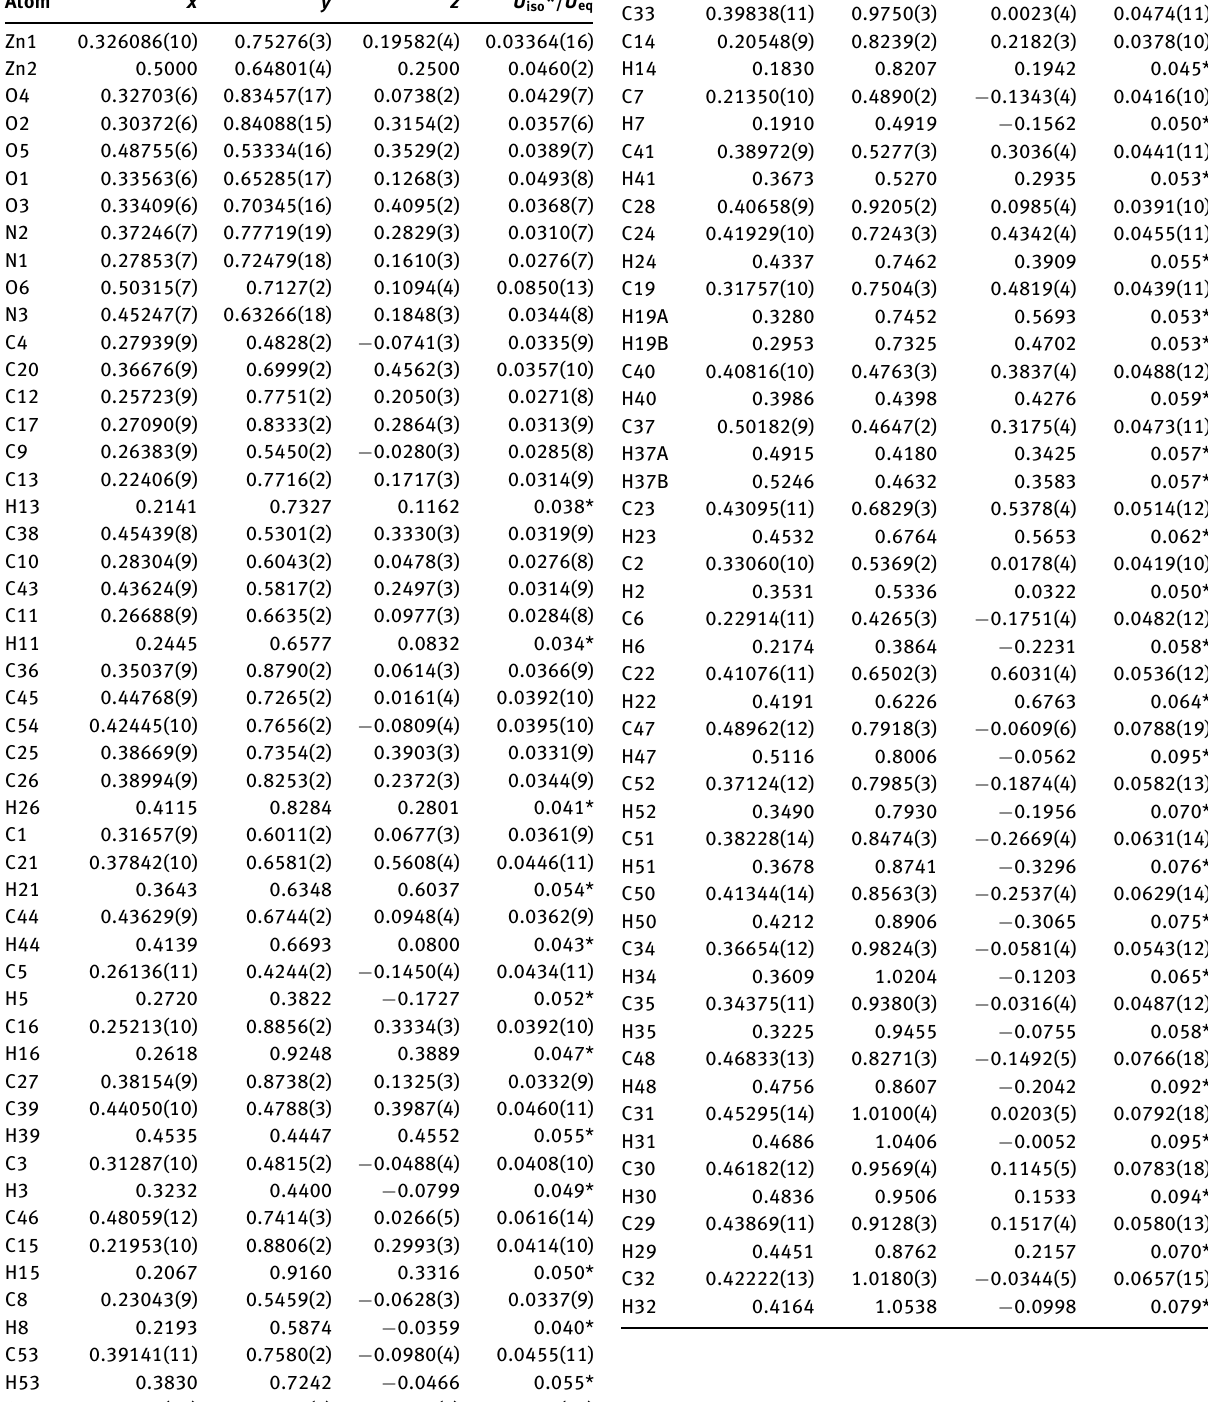
Table 2: Fractional atomic coordinates and isotropic or equivalent isotropic displacement parameters (Å 2